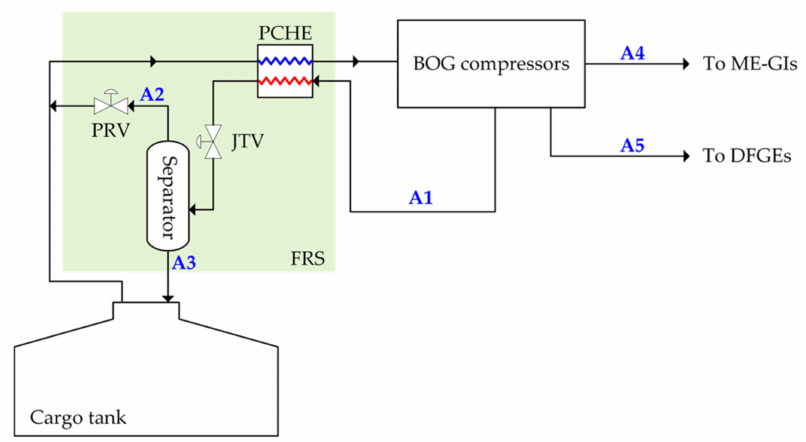
Figure 25. Schematic diagram of the main flowrate.